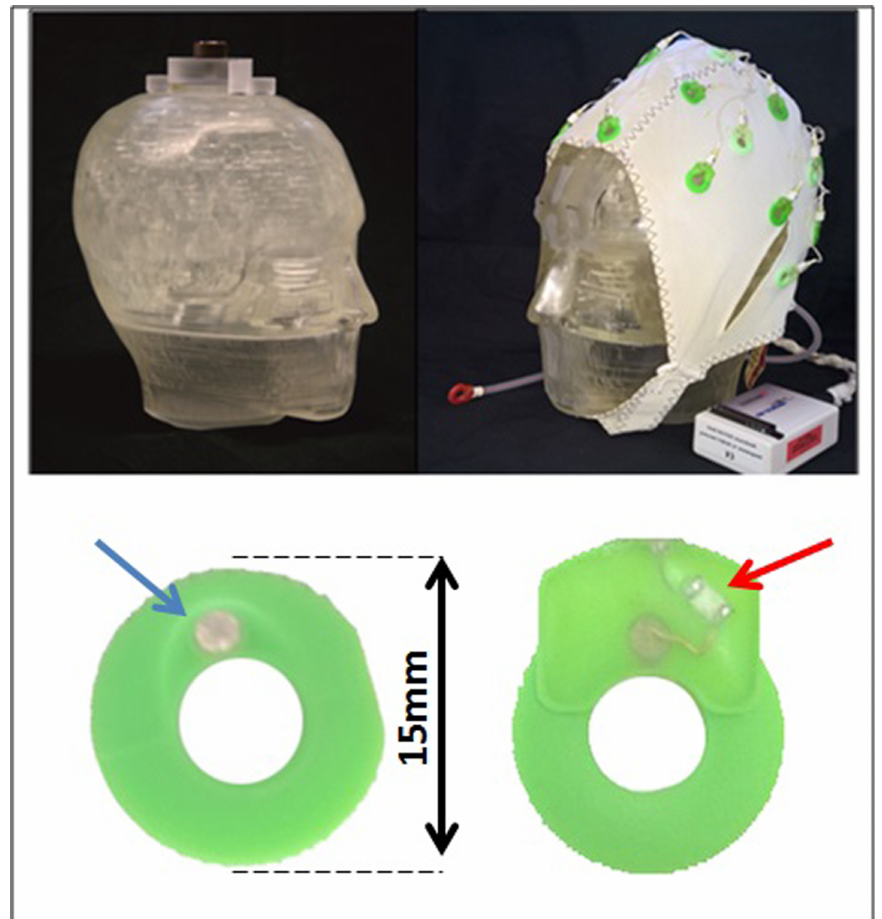
Fig 1. Iida phantom (upper row) without (left) and with (right) MR compatible BrainCap MR EEG cap. The BrainCapMR—Ag/AgCl electrode(indicatedby the blue arrow) is embedded in a green plastic housing (lower row—left) and front view of the electrode housingshowingthe chip resistor (indicatedby the red arrow) and soldered wire connectionto the Ag/AgCl electrode(lowerrow—right).